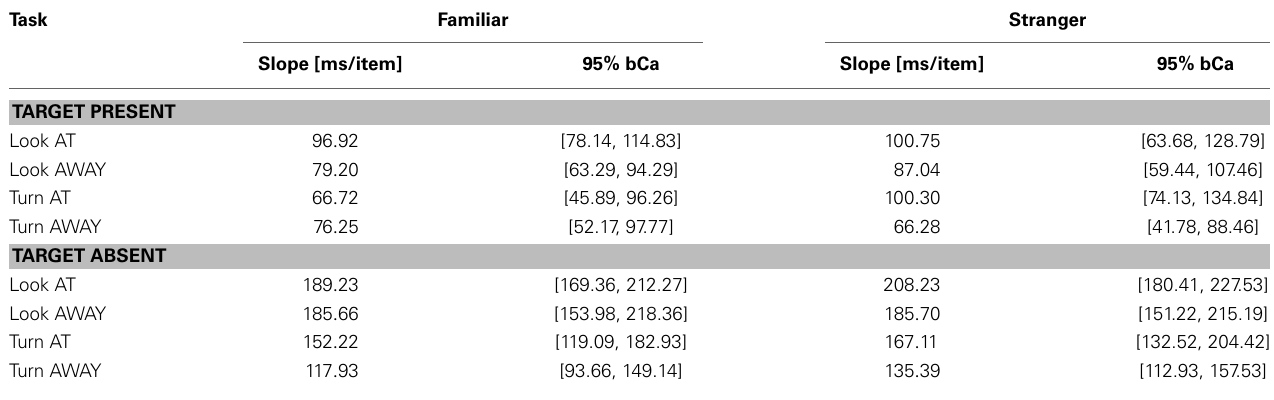
Table 5 | RSF slope estimates for Target Present and Target Absent conditions for the four tasks and for Familiar/Stranger targets (bCa bias-corrected and accelerated confidence intervals, computed with 10,000